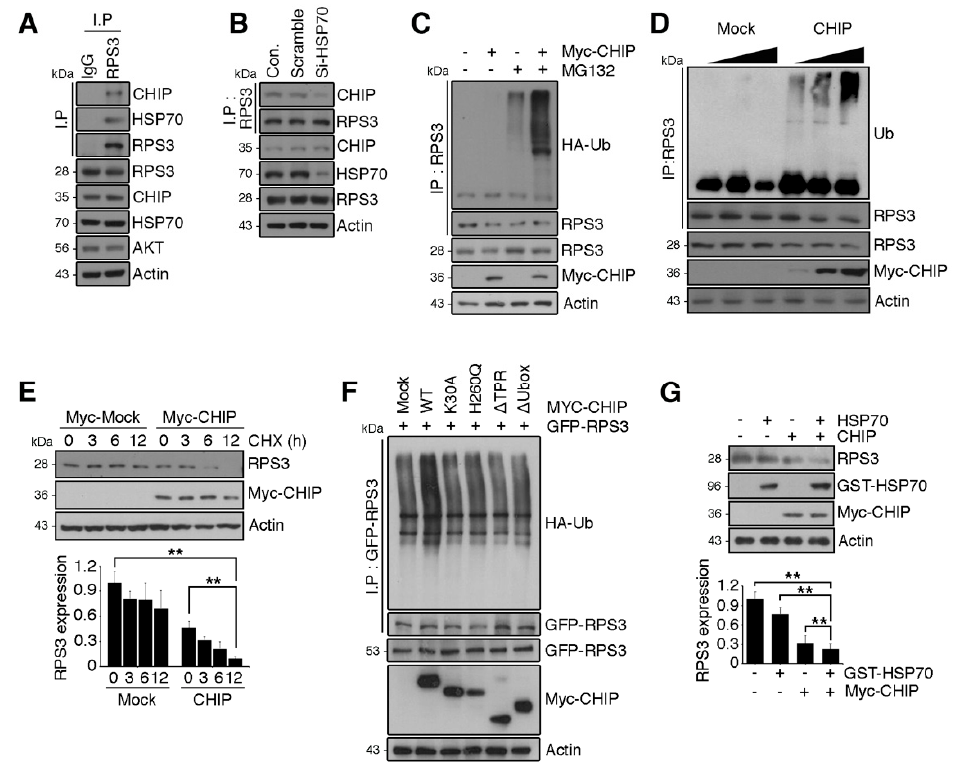
Figure 4. RPS3 is a novel substrate of a chaperone-E3 ligase complex heat shock protein 70 (HSP70)–CHIP (carboxy terminus of HSP70-interacting protein) for degradation. ( A ) HEK 293T cell protein lysates were subjected to immunoprecipitation with an anti-IgG or anti-RPS3 antibody and subjected to immunoblotting with anti-CHIP, HSP70, or Akt antibodies. ( B ) Lysates of 293T cells transfected with si-RNA scrambled or si-HSP70 were subjected to immunoprecipitation with the anti-RPS3 antibody and immunoblotting with an anti-CHIP antibody. Endogenous HSP70 protein levels were analyzed by means of the anti-HSP70 antibody. ( C ) Cortical neurons were transfected with Myc-tagged CHIP or its control vector, and the cells were incubated with or without the proteasome inhibitor MG132. The neurons were lysed and processed for immunoprecipitation with the anti-RPS3 antibody. Ubiquitination levels of endogenous RPS3 were measured by immunoblotting with the anti-HA antibody. Immunoprecipitation was performed to detect ubiquitinated RPS3. ( D ) 293T cells were transfected with various amounts of Myc-CHIP (2/4 µ g), and the cell lysates were subjected to immunoprecipitation with the anti-RPS3 antibody. Ubiquitinated RPS3 was detected by immunoblotting. ( E ) Transfected 293T cells were treated with cycloheximide (CHX, 10 µ M) at the indicated time points (0, 3, 6, or 12 h) and probed during the immunoblotting with an anti-RPS3, anti-Myc, or anti-actin antibody (upper panel). Quantification of the RPS3 protein levels by densitometry analysis (bottom). ( F ) Cells were co-transfected with Myc-CHIP WT or various mutant versions: ∆ TPR, K30A, ∆ Ubox, or H260Q, as well as GFP-RPS3. The transfected cells were incubated with MG132. Ubiquitinated RPS3 was quantified by means of the anti-HA antibody. ( G ) Myc-CHIP was co-transfected with GST-HSP70 into 293T cells, and protein levels of RPS3 were detected with the anti-RPS3 antibody (top). Quantification of the RPS3 protein levels by densitometric analysis (bottom). Densities of immunoblotting were measured with Image J and their values were normalized with normal cell lysate or control. Statistical significance was calculated using a one-way ANOVA test followed by Turkey’s post-test (* p < 0.01; ** p < 0.001). Values in this figure represent mean ± SEM from three independent experiments, and the image shown is representative of at least three independent experiments.